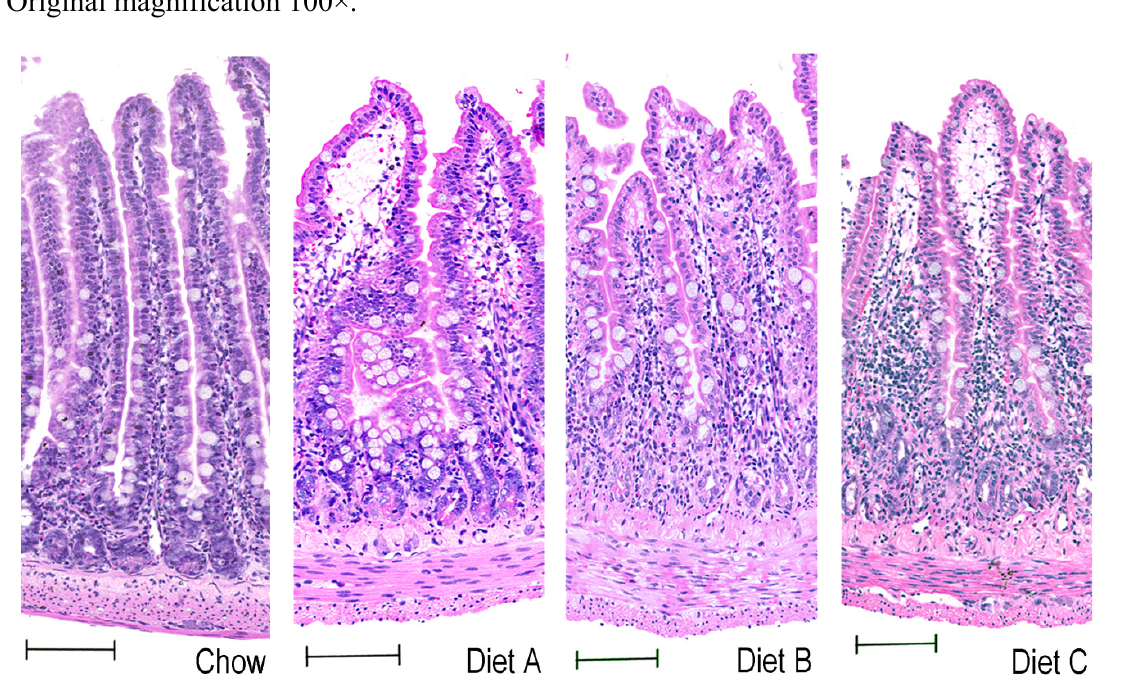
Figure 6. Representative photomicrographs of H & E-stained jejunum of MTX-treated animals (day 2), receiving Chow control, Diet A, Diet B and Diet C. Bars represent 100 μ m. Original magnification